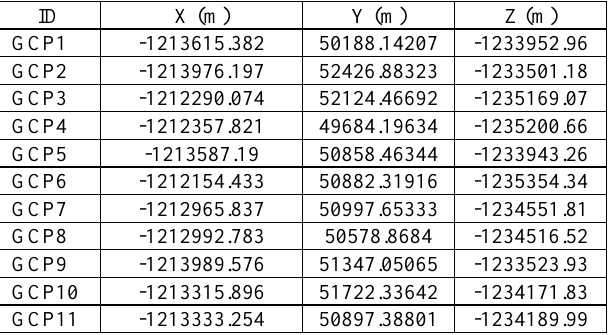
Table 1. The Cartesian coordinates of GCPs